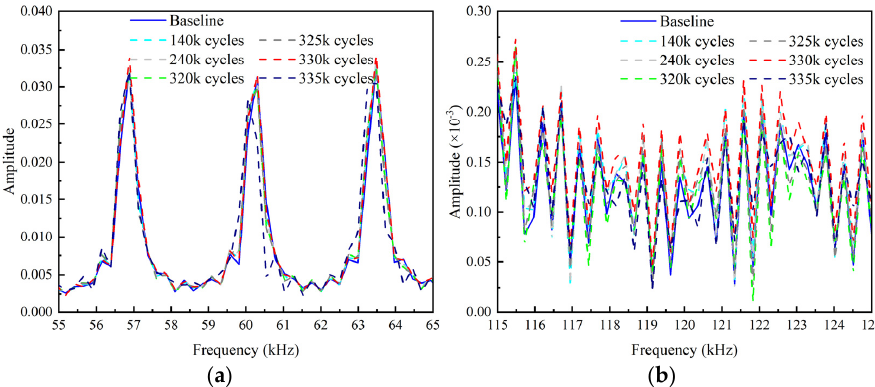
Figure 28. Frequency spectrums after various loading cycles. ( a ) Fundamental frequency spectrums around central frequency; ( b ) Second harmonic frequency spectrums around double of central frequency.